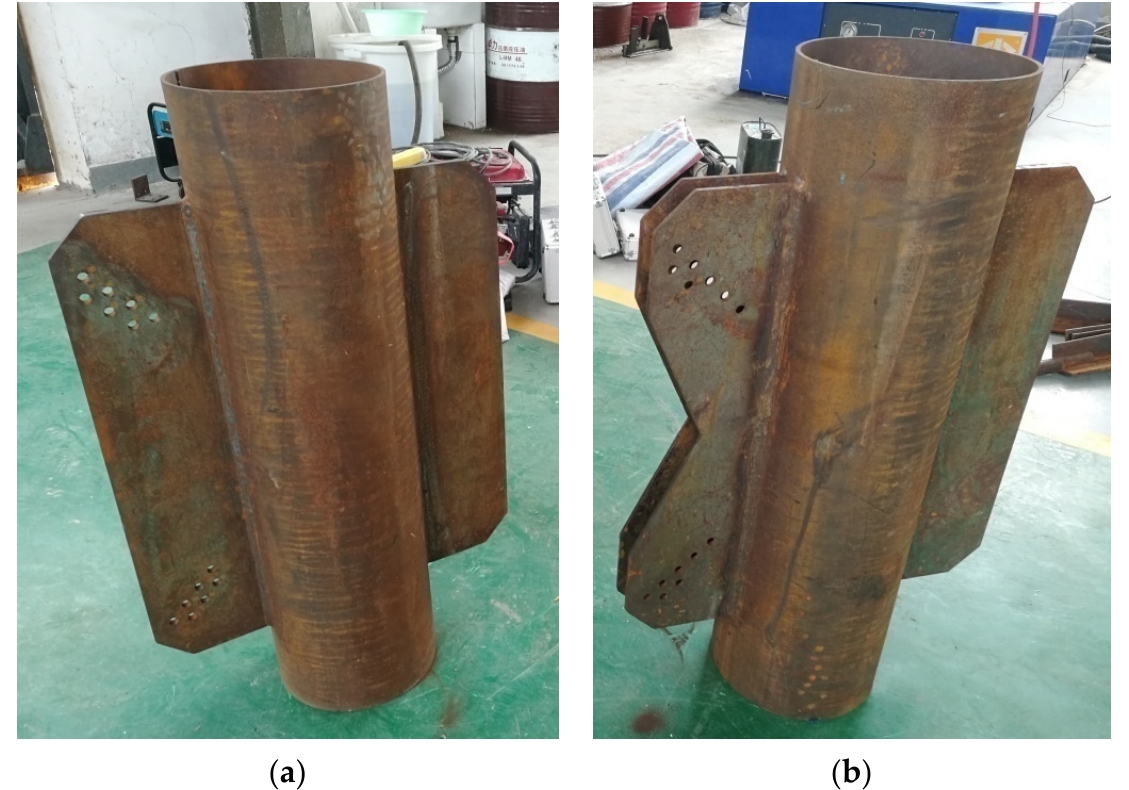
Figure 4. ( a ) 1: 5 scale joint test model of SLSPJ; ( b ) 1: 5 scale joint test model of DLDPJ.